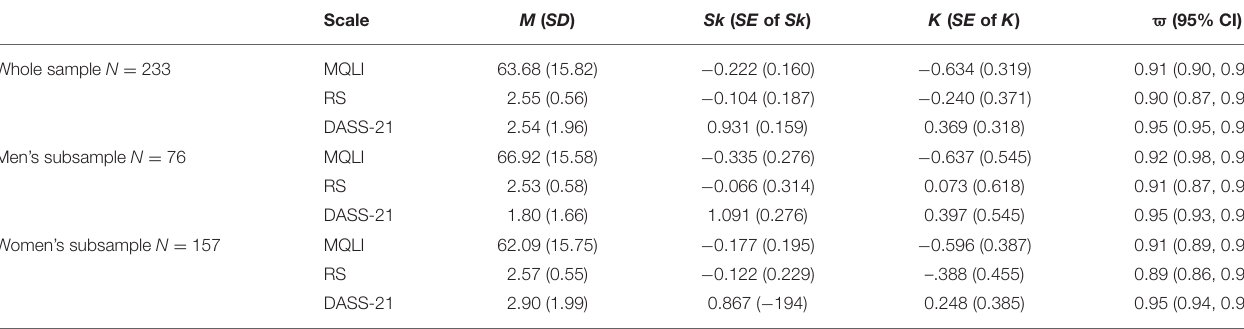
TABLE 1 | Descriptive statistics and internal consistency of the scales used in the present study.